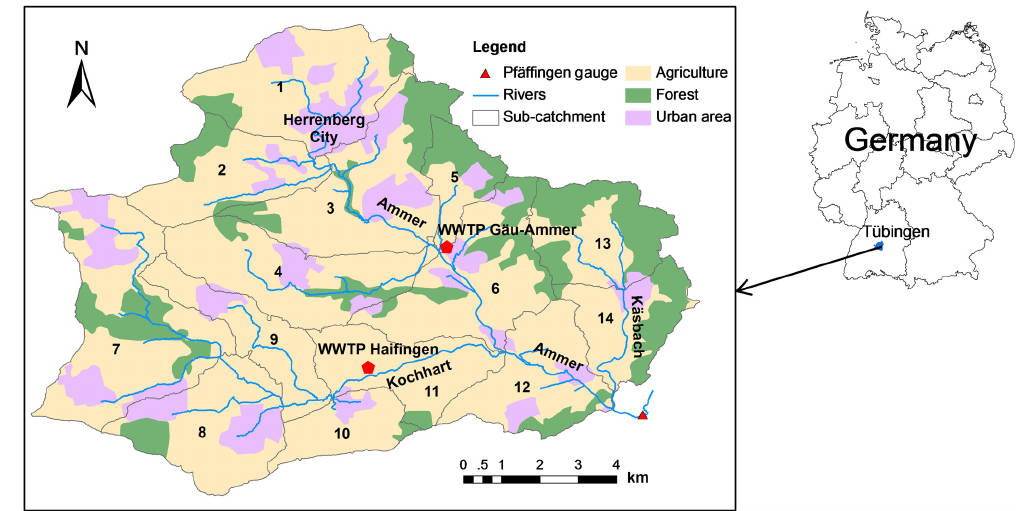
Figure 1. Location of the Ammer catchment and its subcatchments, rivers, and land uses. The numbers show identifiers of 14 subcatchments that are characterized in more detail in Table 1. Two red regular pentagons represent two WWTPs in the study domain. The red triangular indicates the gauge at the catchment outlet. Table 1. Properties of the Ammer